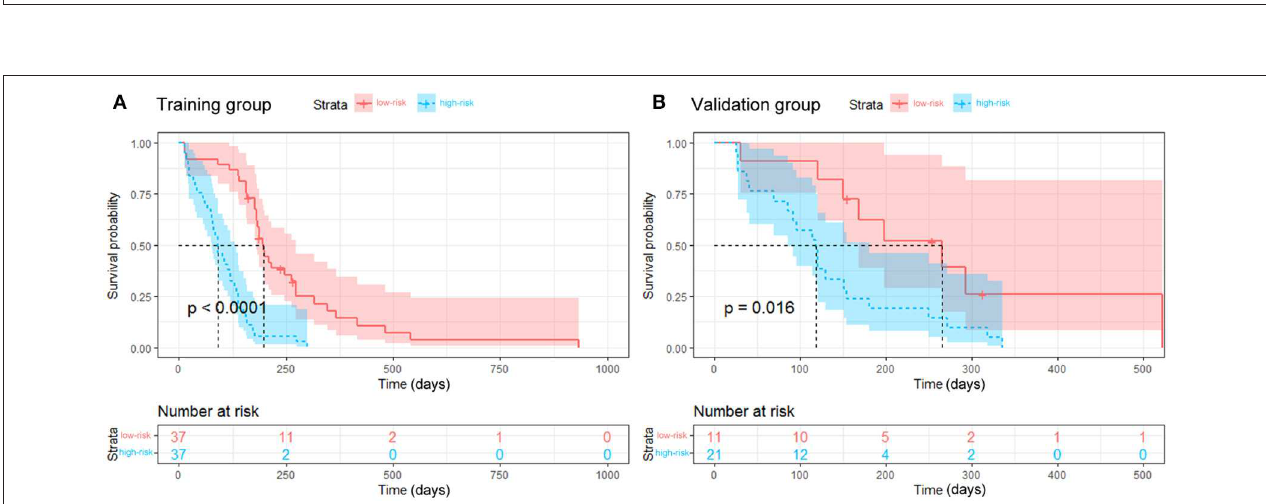
FIGURE 5 | Kaplan-Meier curves for the stratified groups. The low-risk group had a longer RFS than the high-risk group in the training group ( A , p < 0.001) and the validation group ( B , p = 0.016).